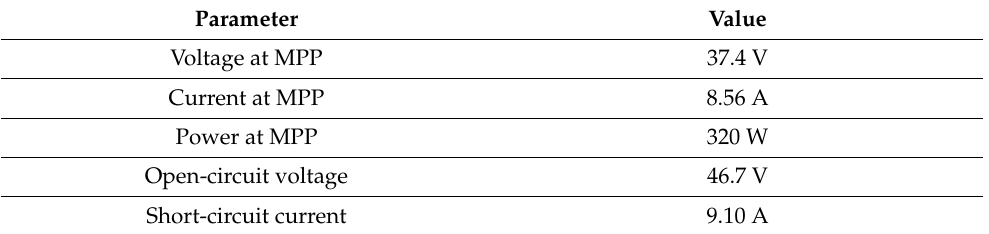
Table 1. Characteristics of the PV panels used in the proposed pumping system (in STC